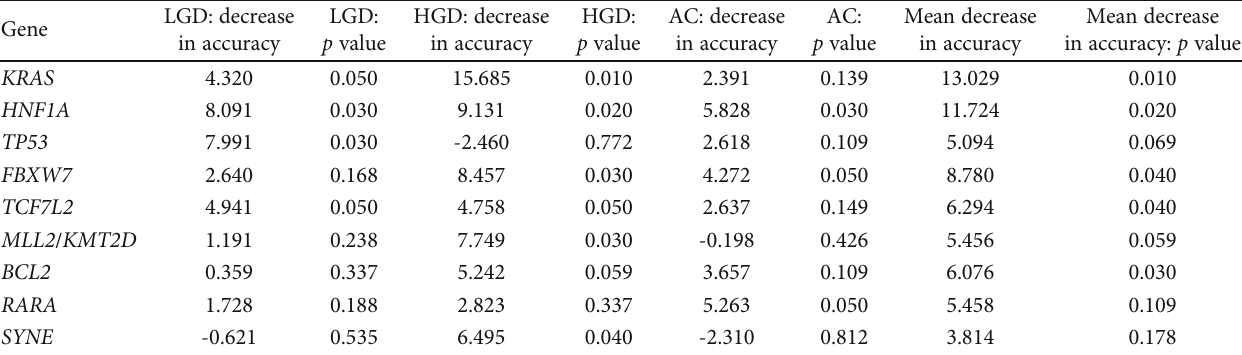
Table 3: Random forest classi fi er results for di ff erent groups with a decrease in accuracy for each group, p values computed by the rfPermute package, and a mean decrease in accuracy for overall classi fi